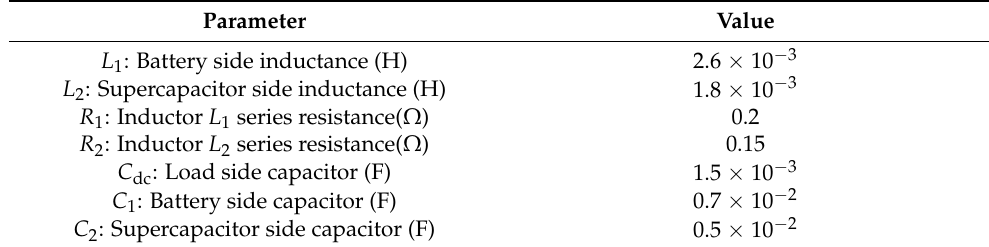
Table 1. The component parameters of HESS.